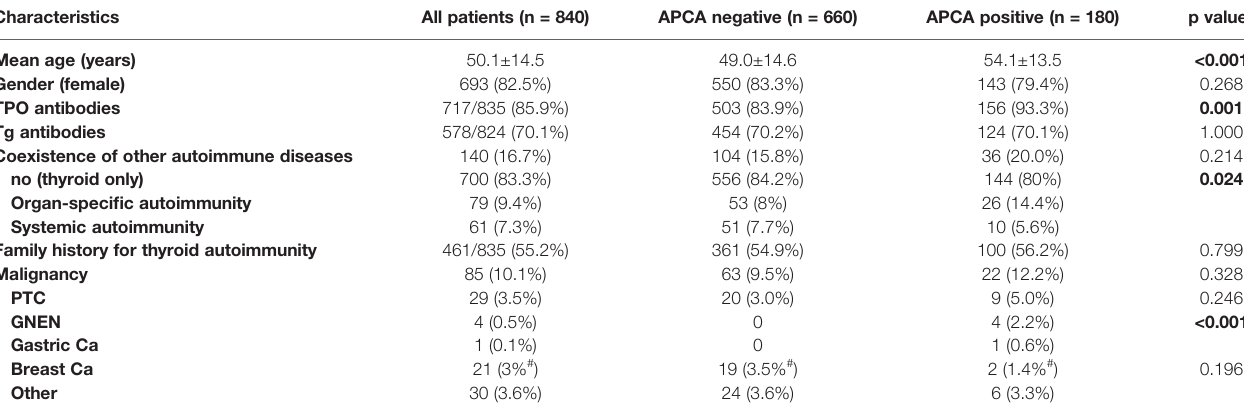
TABLE 1 | Clinical characteristics of APCA-negative and APCA-positive patients with HT (n=840).